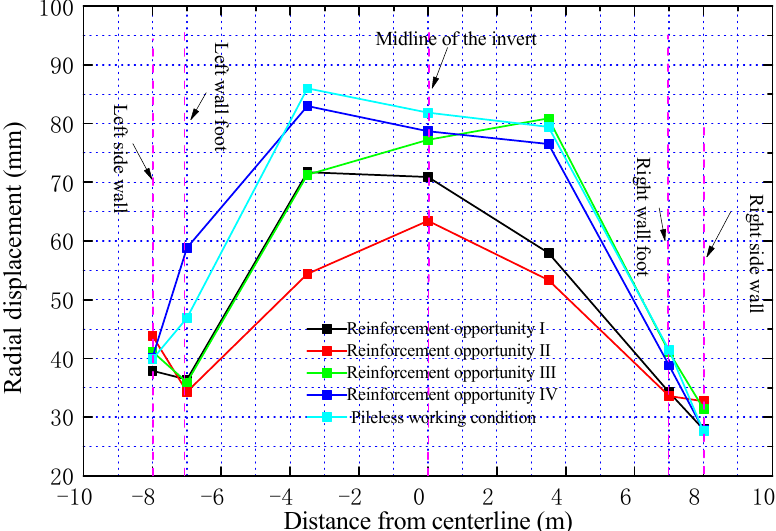
Figure 7. Radial displacement of base and side wall (different reinforcement times).